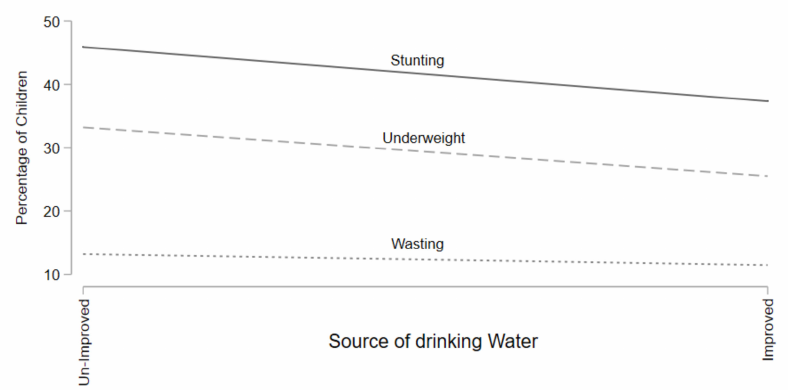
Figure 2. Prevalence of Stunting, Underweight, and Wasting for Water